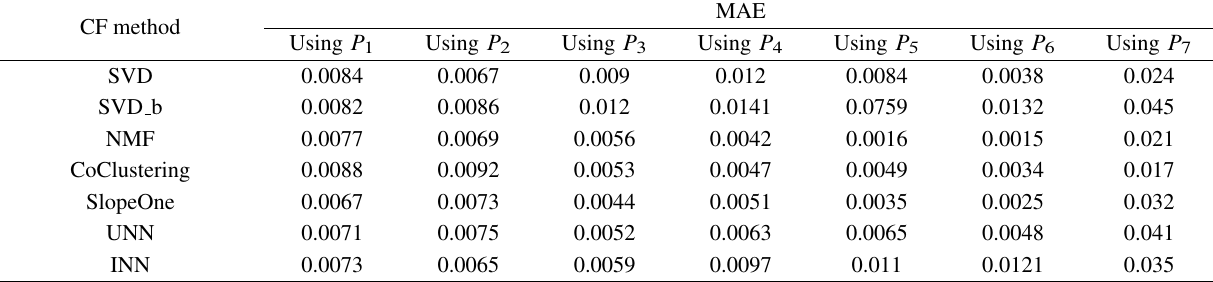
Table 6 Evaluation of the AL model in Eq.